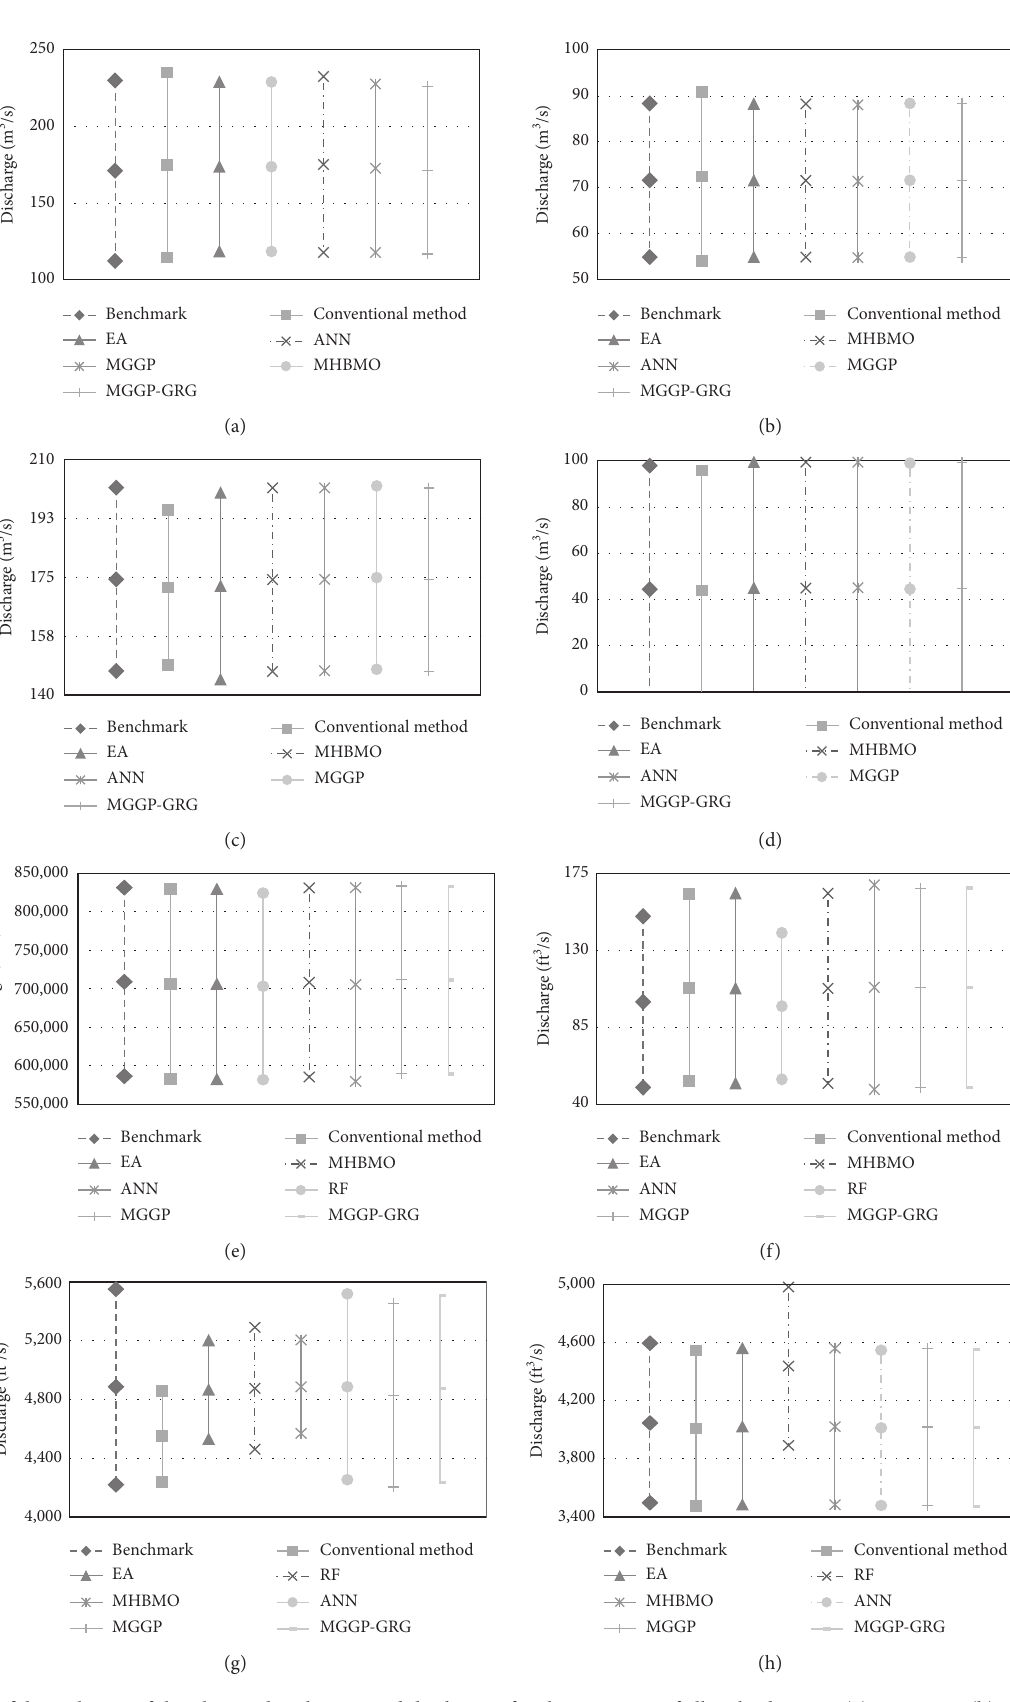
Figure 7: Confidence limits of the observed and estimated discharges for the test parts of all eight datasets. (a) Dataset 1. (b) Dataset 2. (c) Dataset 3. (d) Dataset 4. (e) Dataset 5. (f) Dataset 6. (g) Dataset 7. (h) Dataset